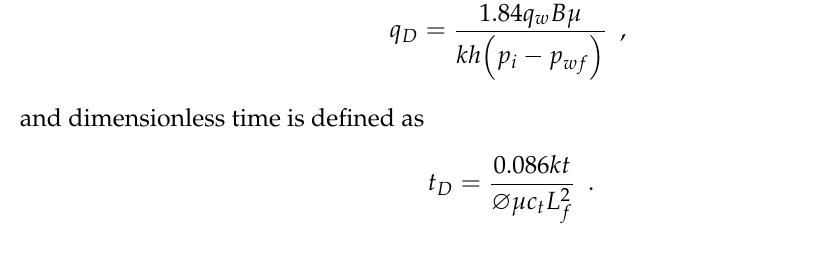
Table 1. Basic parameters of the reservoir and well system for the theoretical case. Porosity 0.2 Reservoir initial pressure (MPa) 34.01 Viscosity (cp) 1 Downhole flowing pressure (MPa) 13.61 Permeability (mD) 2 Compressibility (MPa − 1 ) 0.00118 Thickness (m) 30.48 Formation volume factor 1 Fracture stage 5 Reservoir width (m) 900 Stage space (m) 90